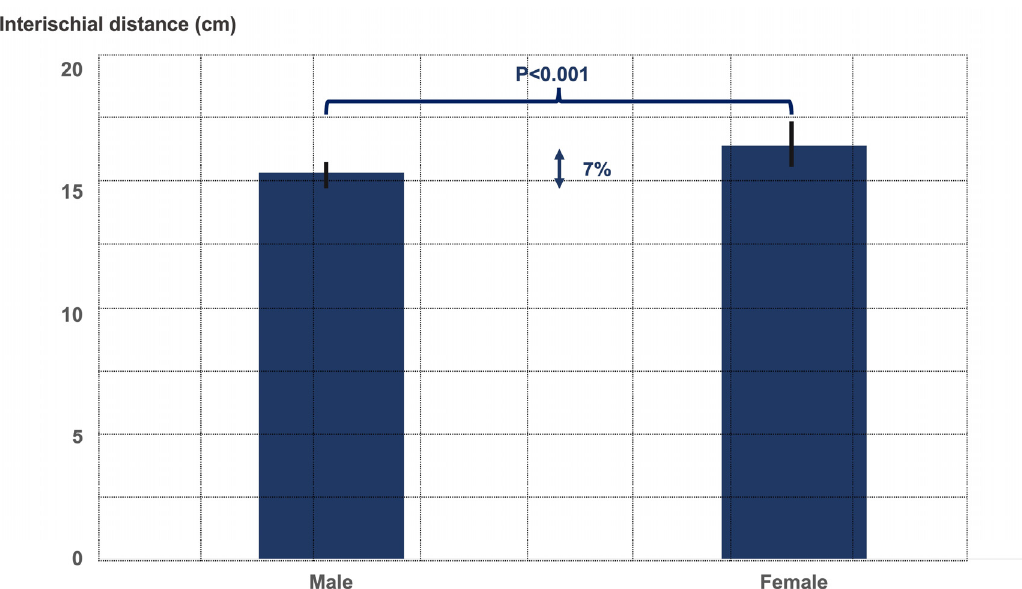
Figure 4. Graph illustrating the interischial distance in males and females.